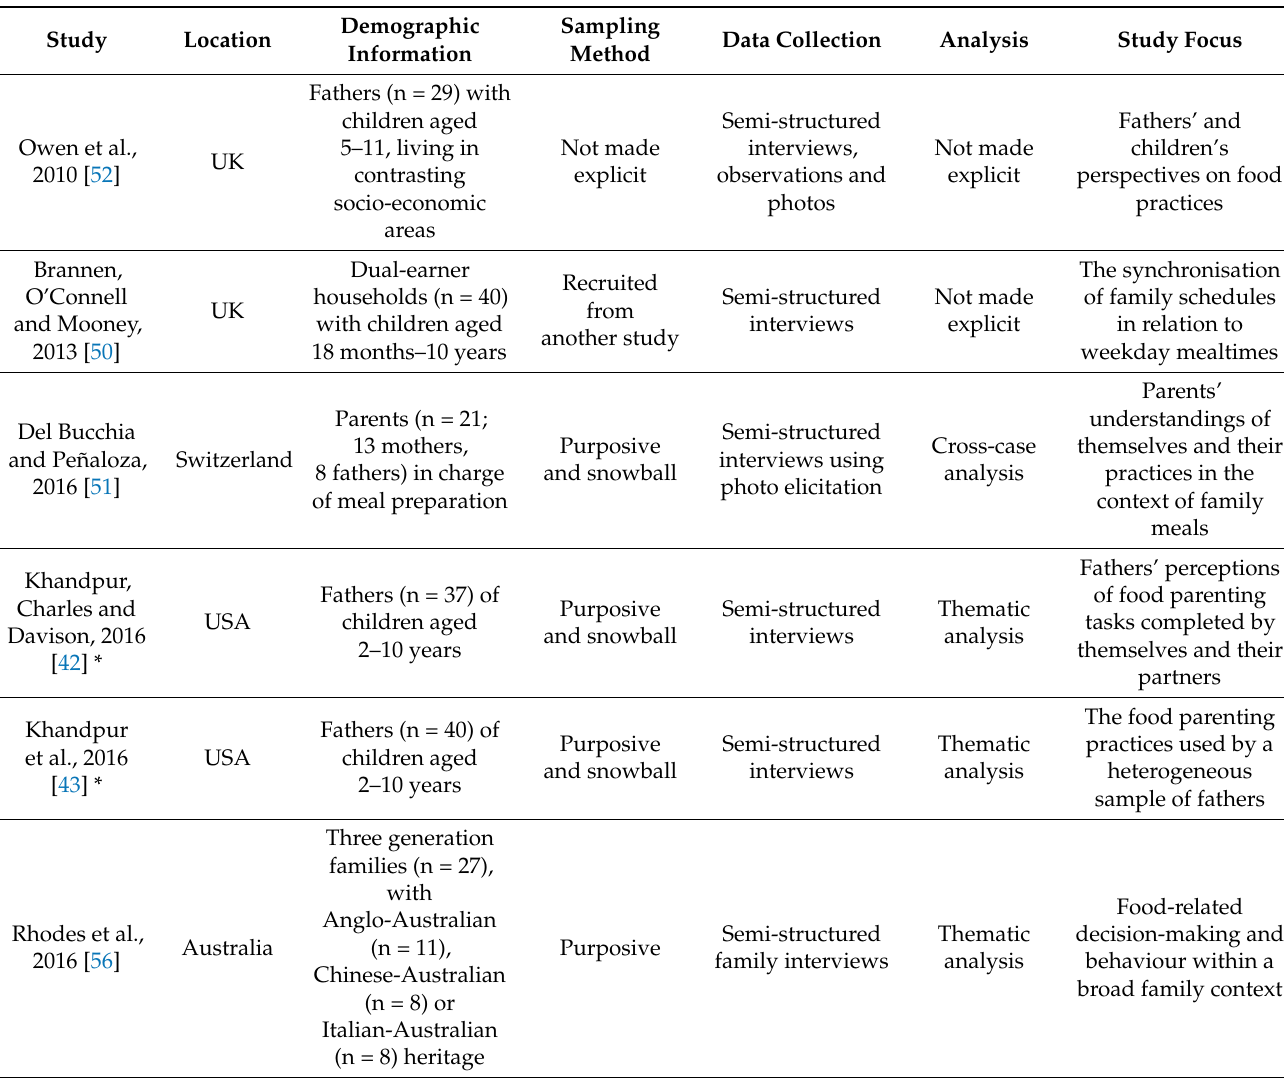
Table 2. Characteristics of selected